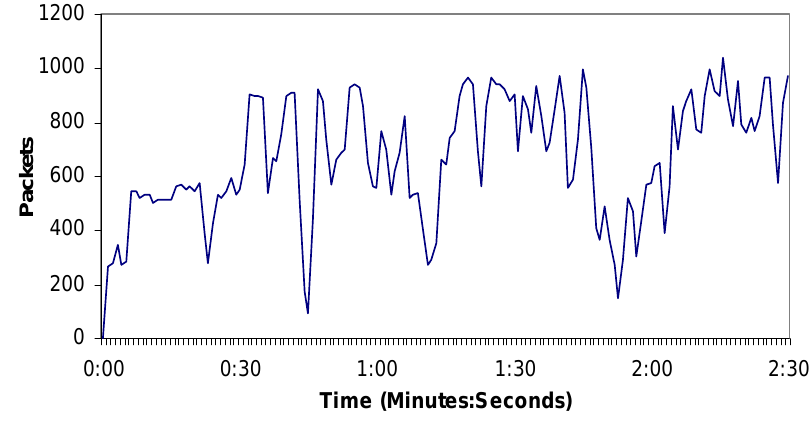
Figure 15. Packets per second when there are four cameras.